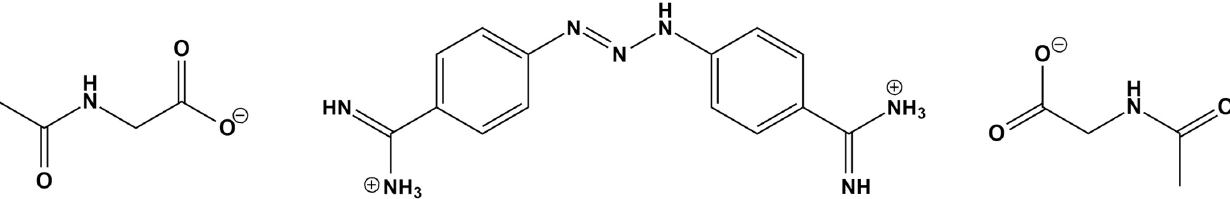
Figure 4. Diminazene reacts with two N-Acetyl glycine (aceturic acid) molecules to afford a salt Diminazene diaceturate. The azene hydrogen is mildly acidic due to the extended aromaticity, which delocalizes the electron pair of nucleophilic nitrogens.